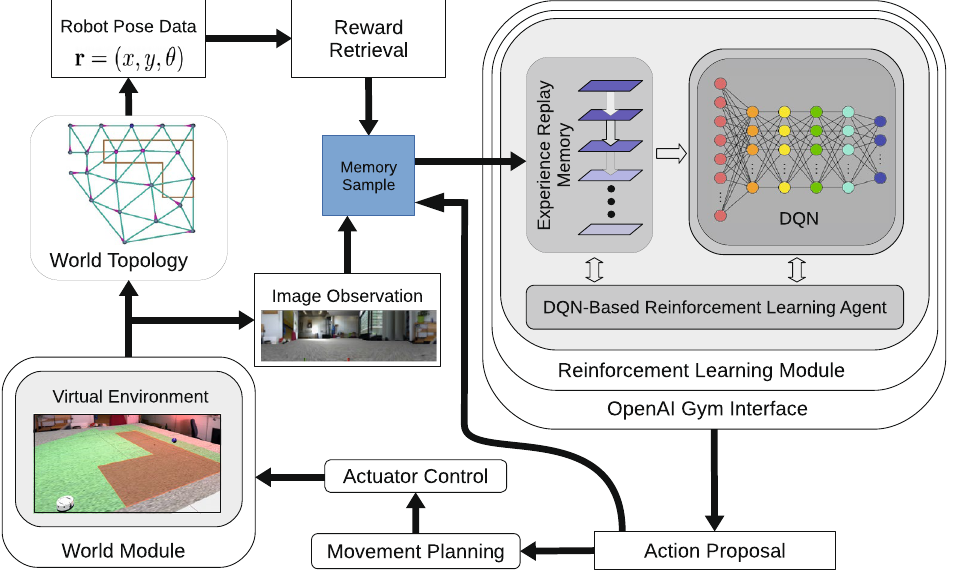
Figure 1. Model overview. Modules are sketched as rounded rectangles, other rectangles represent data and commands, the information/control flow is indicated by arrows. See the “Materials and methods” for an explanation of our